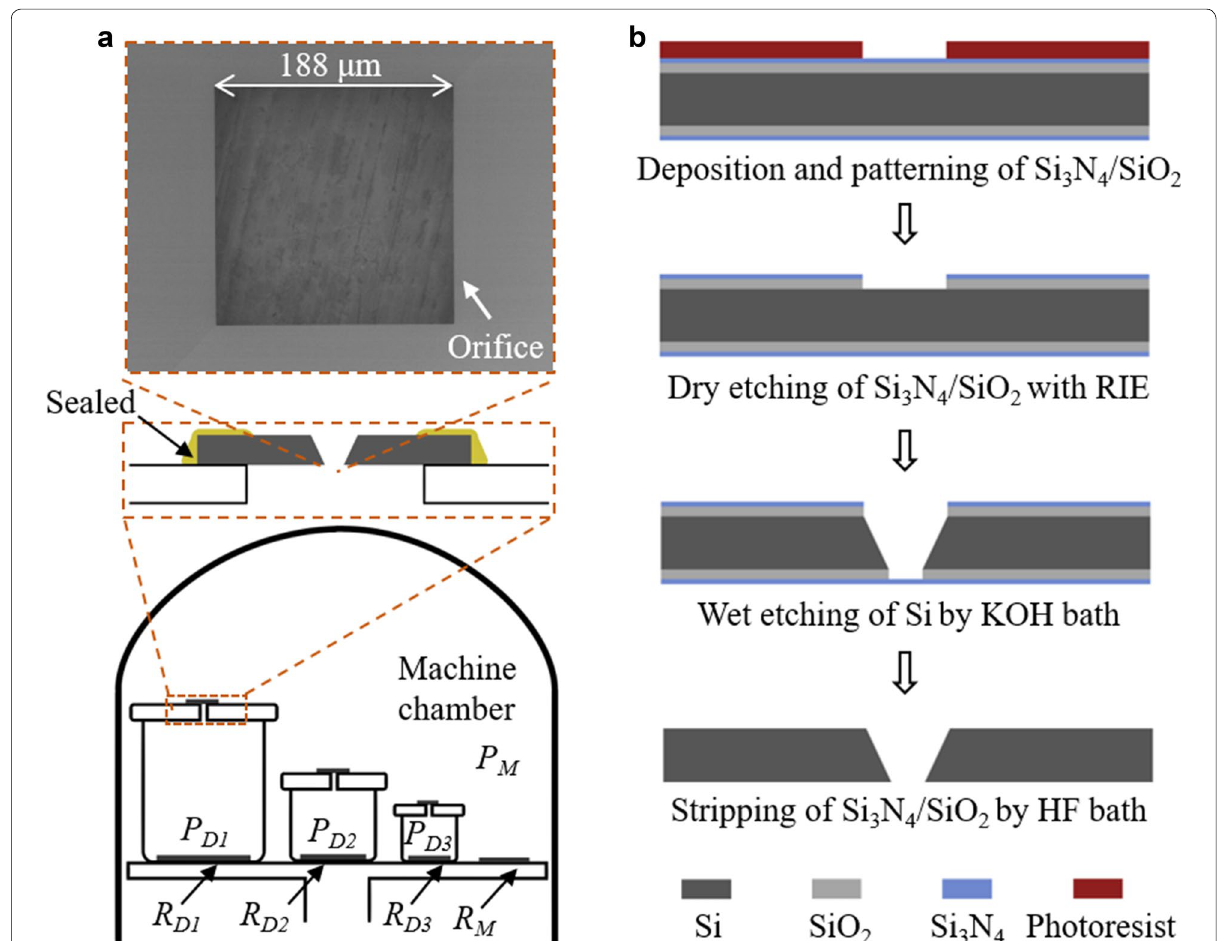
Fig. 2 Working principle of the present ultrathin Parylene deposition (effusion‑based deposition). a The schematic of deposition system with a typical SEM image of the microfabricated orifice. b Schematic of the fabrication process of the orifice